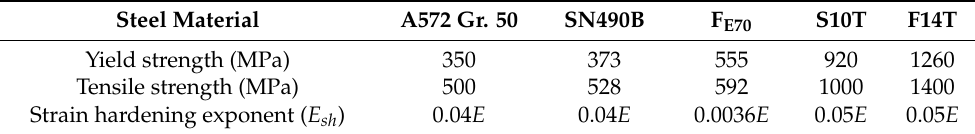
Table 2. Strength parameters of trilinear